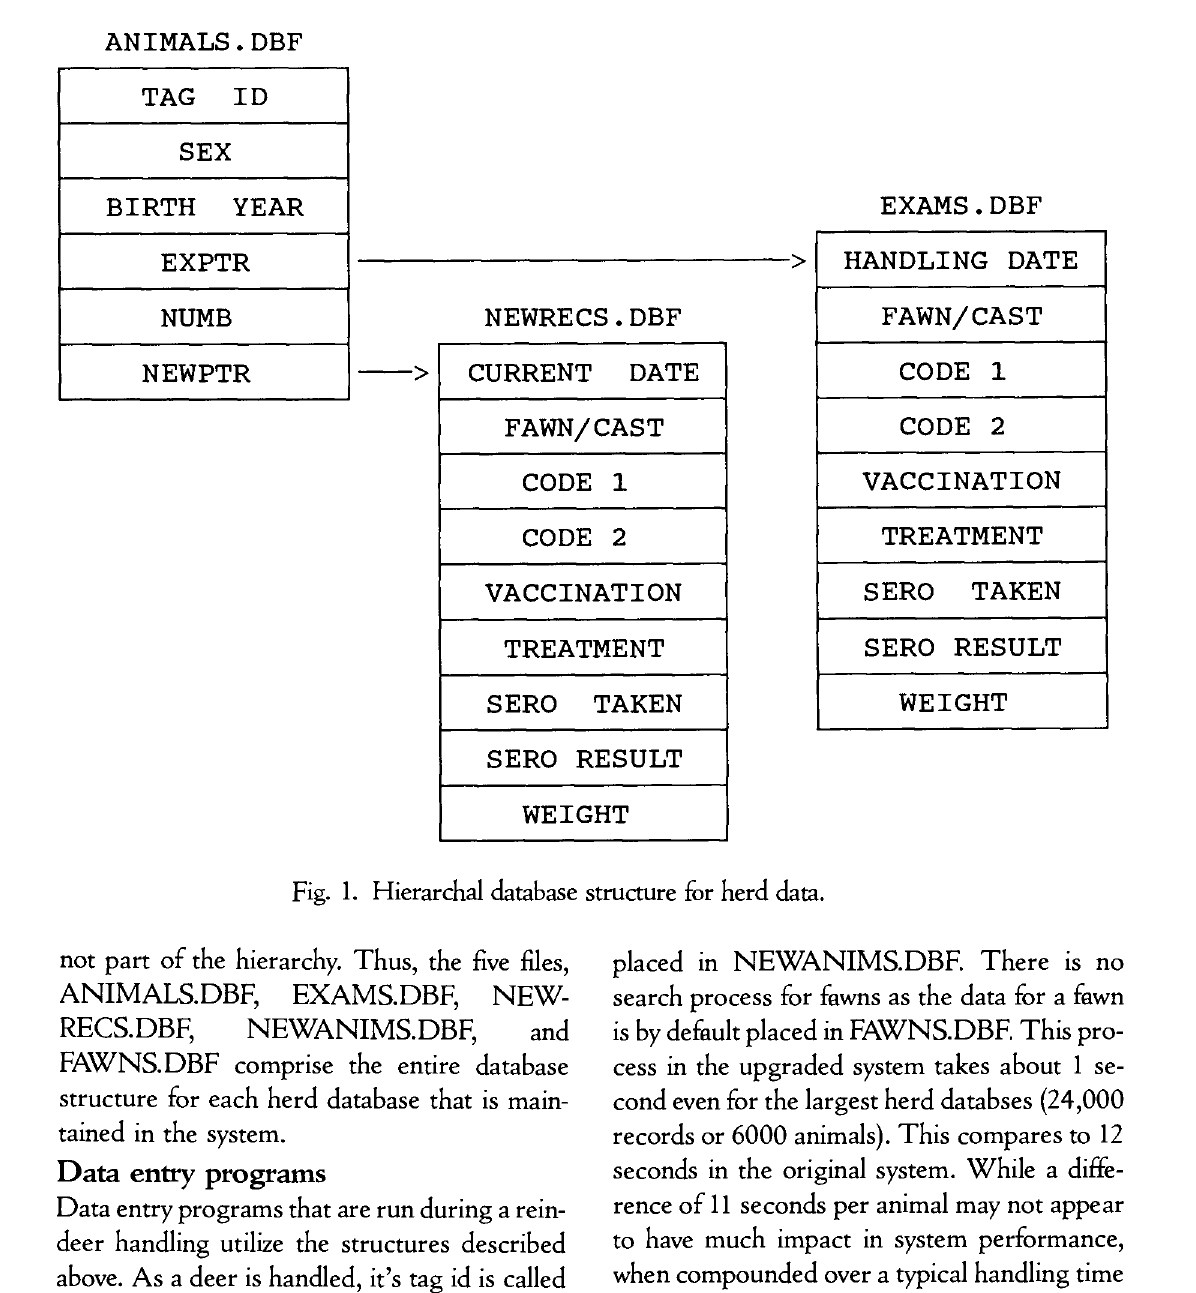
Fig. 1. Hierarchal database structure for herd